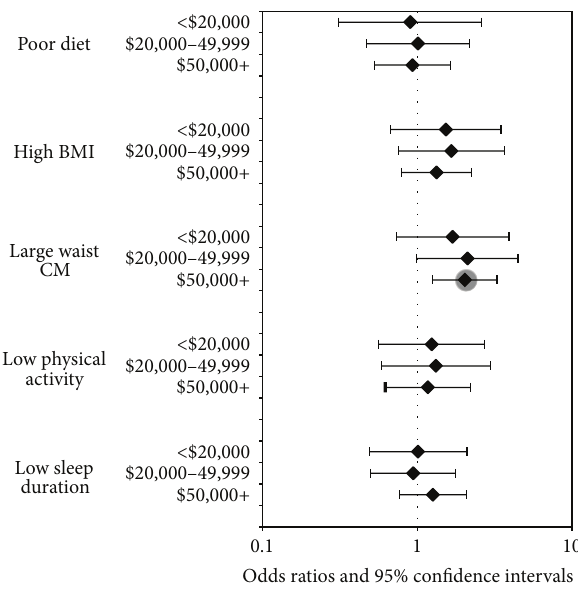
Figure 3: Odds ratio estimates for prediabetes or insulin resistance by income